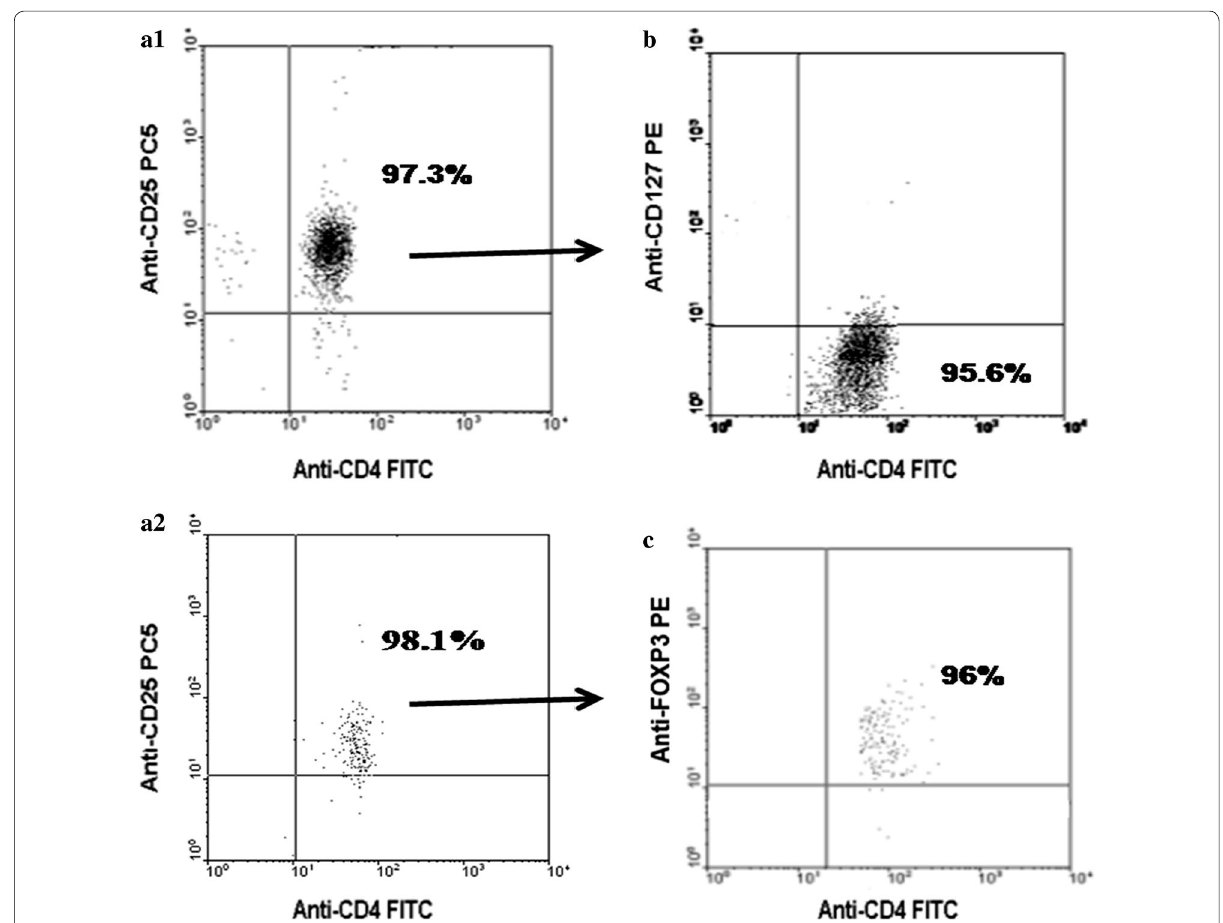
Fig. 4 Purity of isolated CD4 CD25 T cells in vitro and percentage of CD127dim/- and FOXP3 + + of isolated CD4 CD25 T cells in one sample was 97.3%; a2 The purity of isolated CD4 + + percentage of CD127dim/- T cells in isolated CD4 CD25 T cells was 95.6%; c The percentage of FOXP3 + + was 96%. n 8. The gating strategy used is illustrated in Additional file 1: =